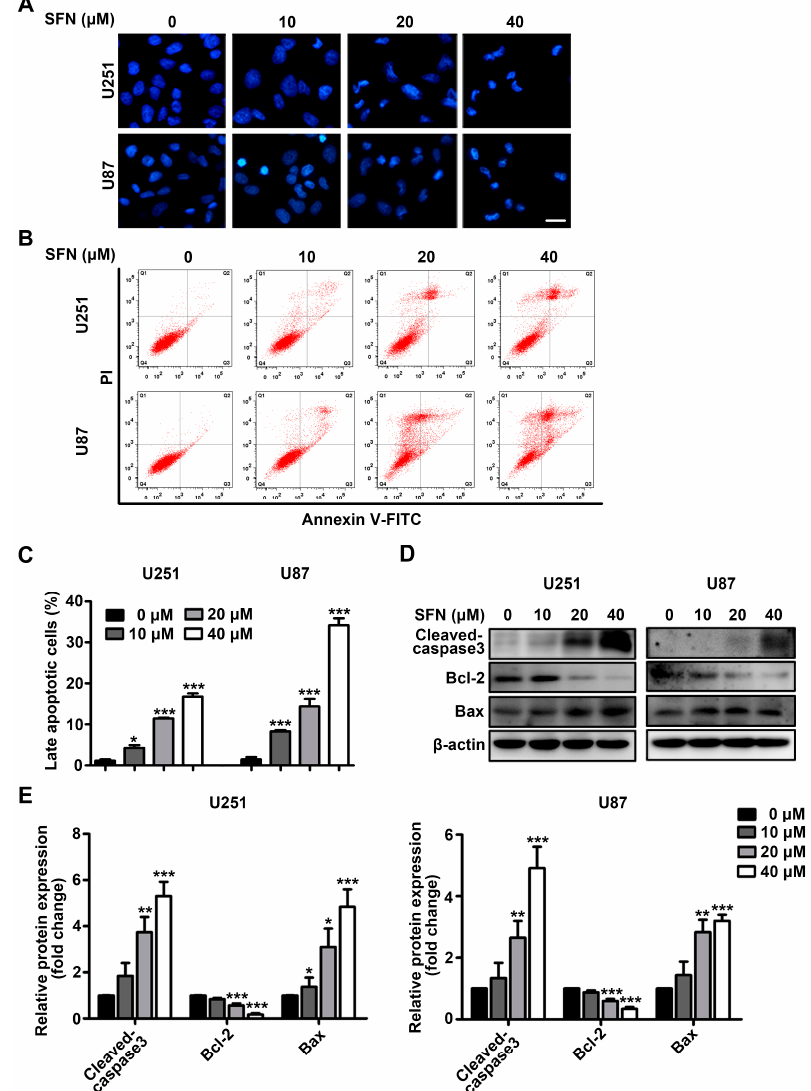
Figure 2. SFN induces apoptosis in GBM cells. The cells were treated with indicated concentrations of SFN for 24 h. ( A ) Nuclear morphology was observed using an inverted microscope after DAPI staining. Bar: 20 µm; ( B ) the induction of apoptosis was analyzed by double staining with Annexin V-FITC/PI, and the apoptosis rate was analyzed by flow cytometry. Cells in Q2 quarters (Annexin V positive/PI negtive) represented early apoptotic cells. The double-positive cells in Q3 quarters represented late apoptotic cells; ( C ) the percentages of late apoptotic cells relative to the total population were quantified; ( D ) Western blot analysis of cleaved caspase-3, Bcl-2, and Bax after SFN treatment; ( E ) the bands corresponding to each protein were quantified and normalized relative to control group. Data are represented as means ± SD. * p < 0.05, ** p < 0.01, and *** p < 0.001 versus control